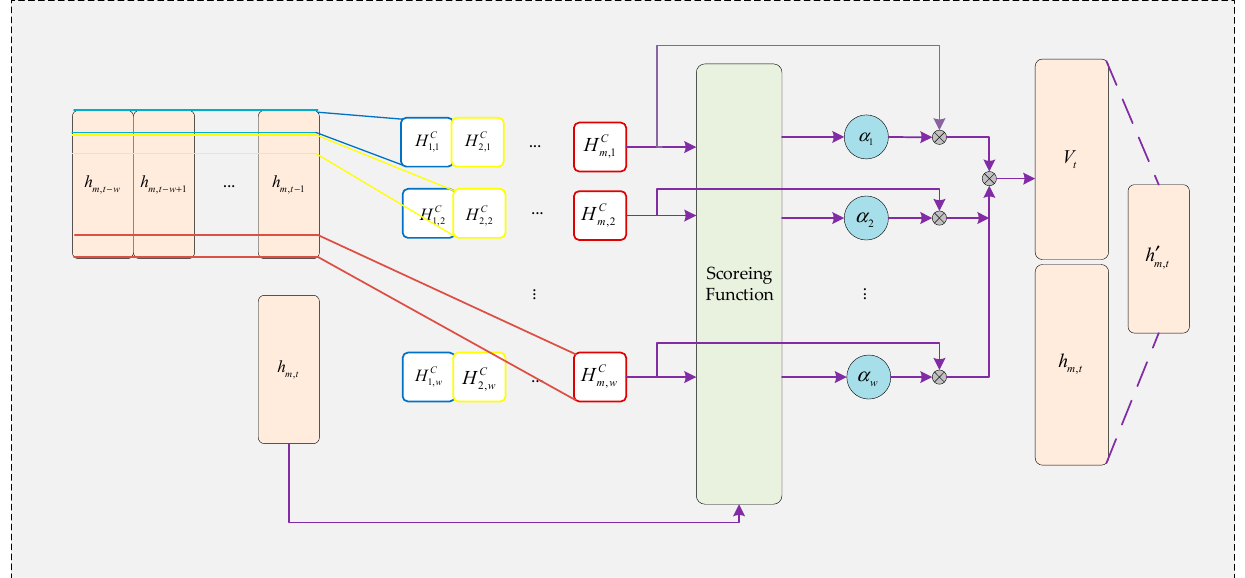
Figure 6. The TPA mechanism.